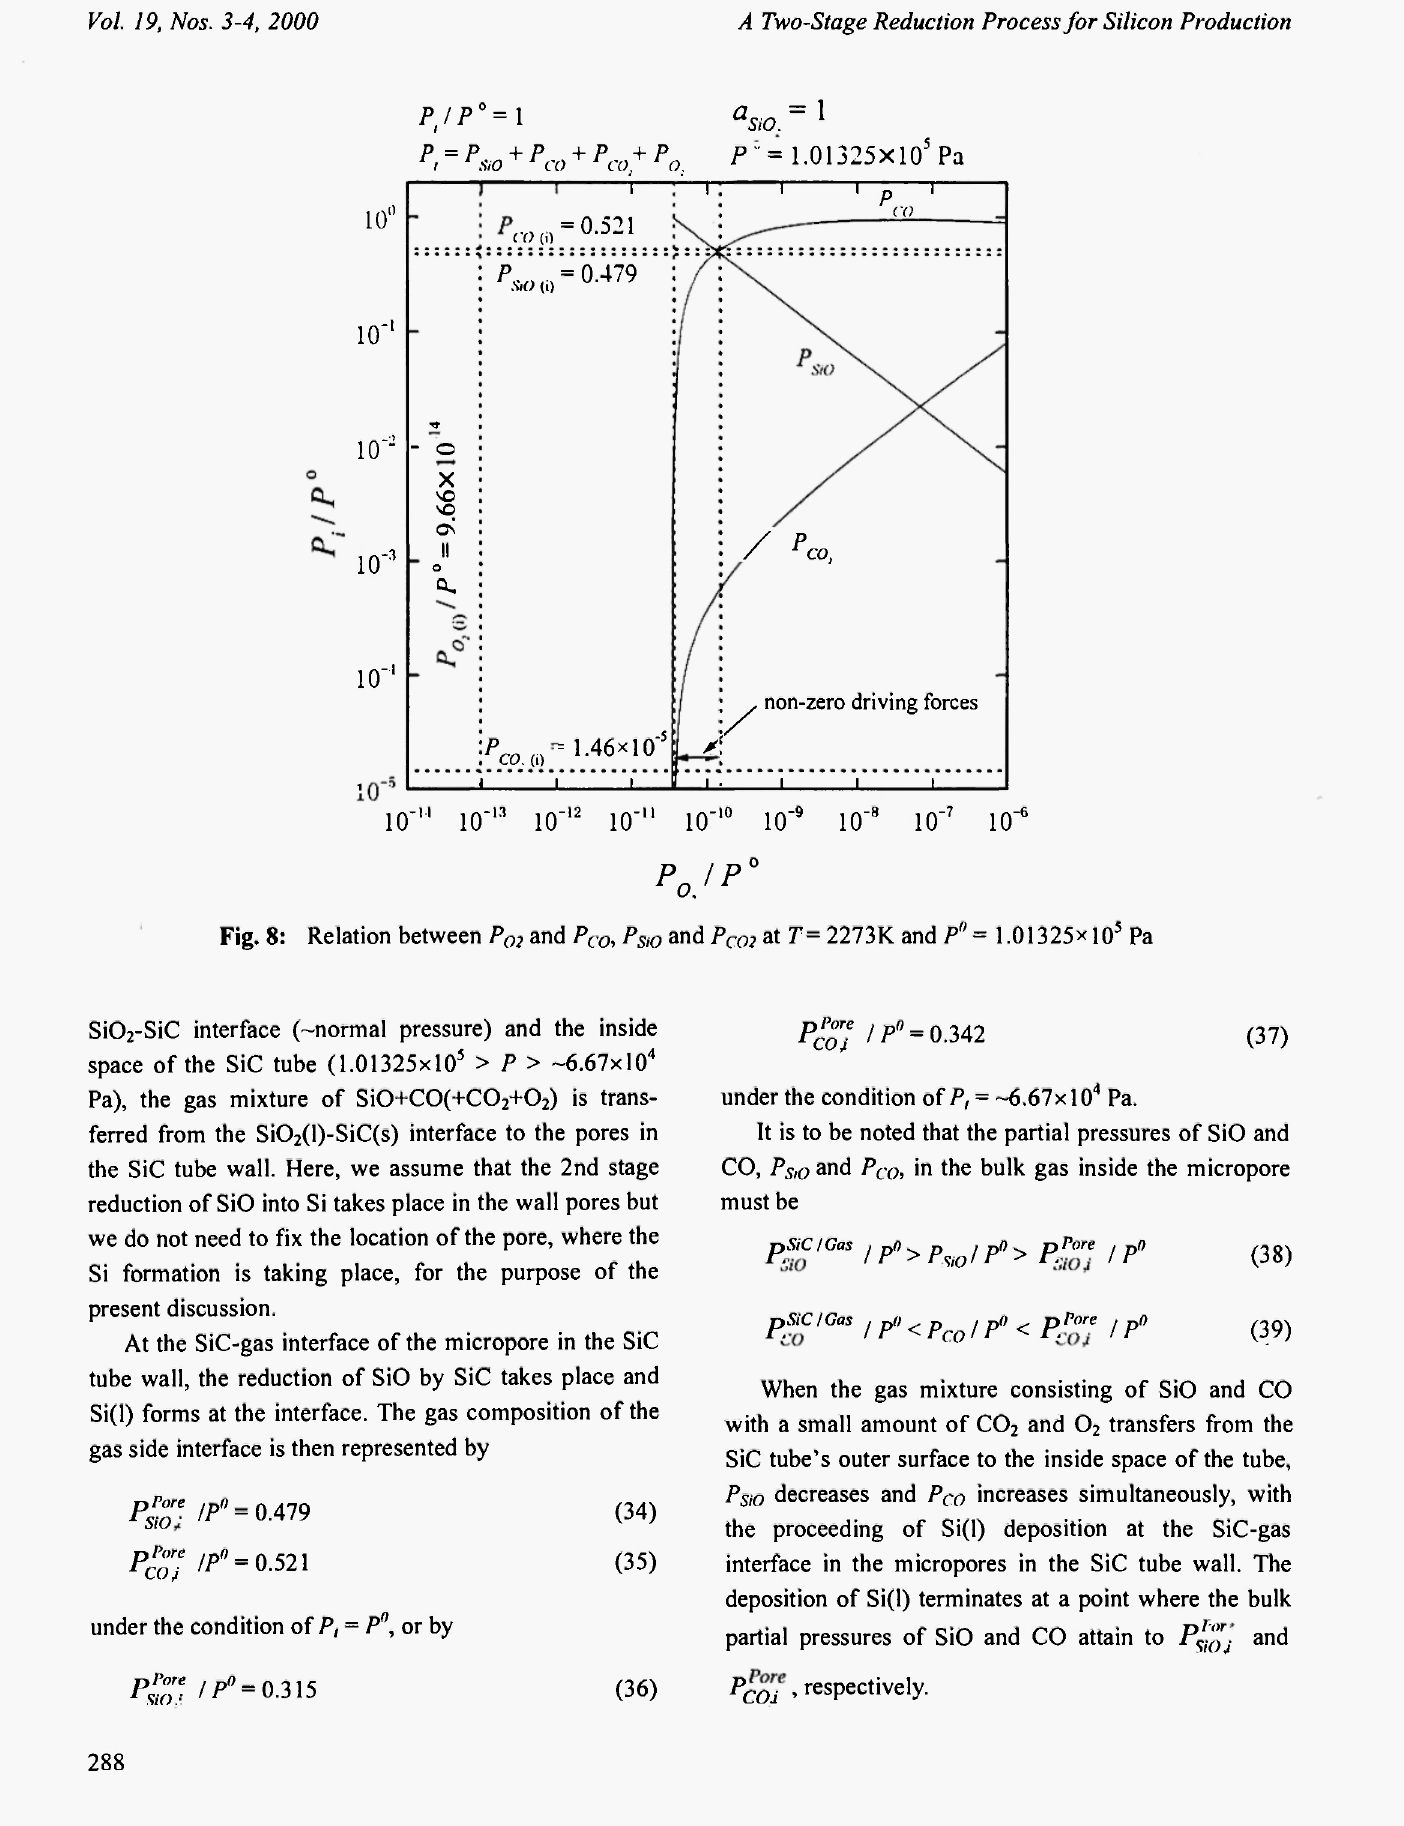
Fig. 8: Relation between P„ 2 and P co , Psto and P c02 at T= 2273K and Ρ" = 1.01325χ 10 5